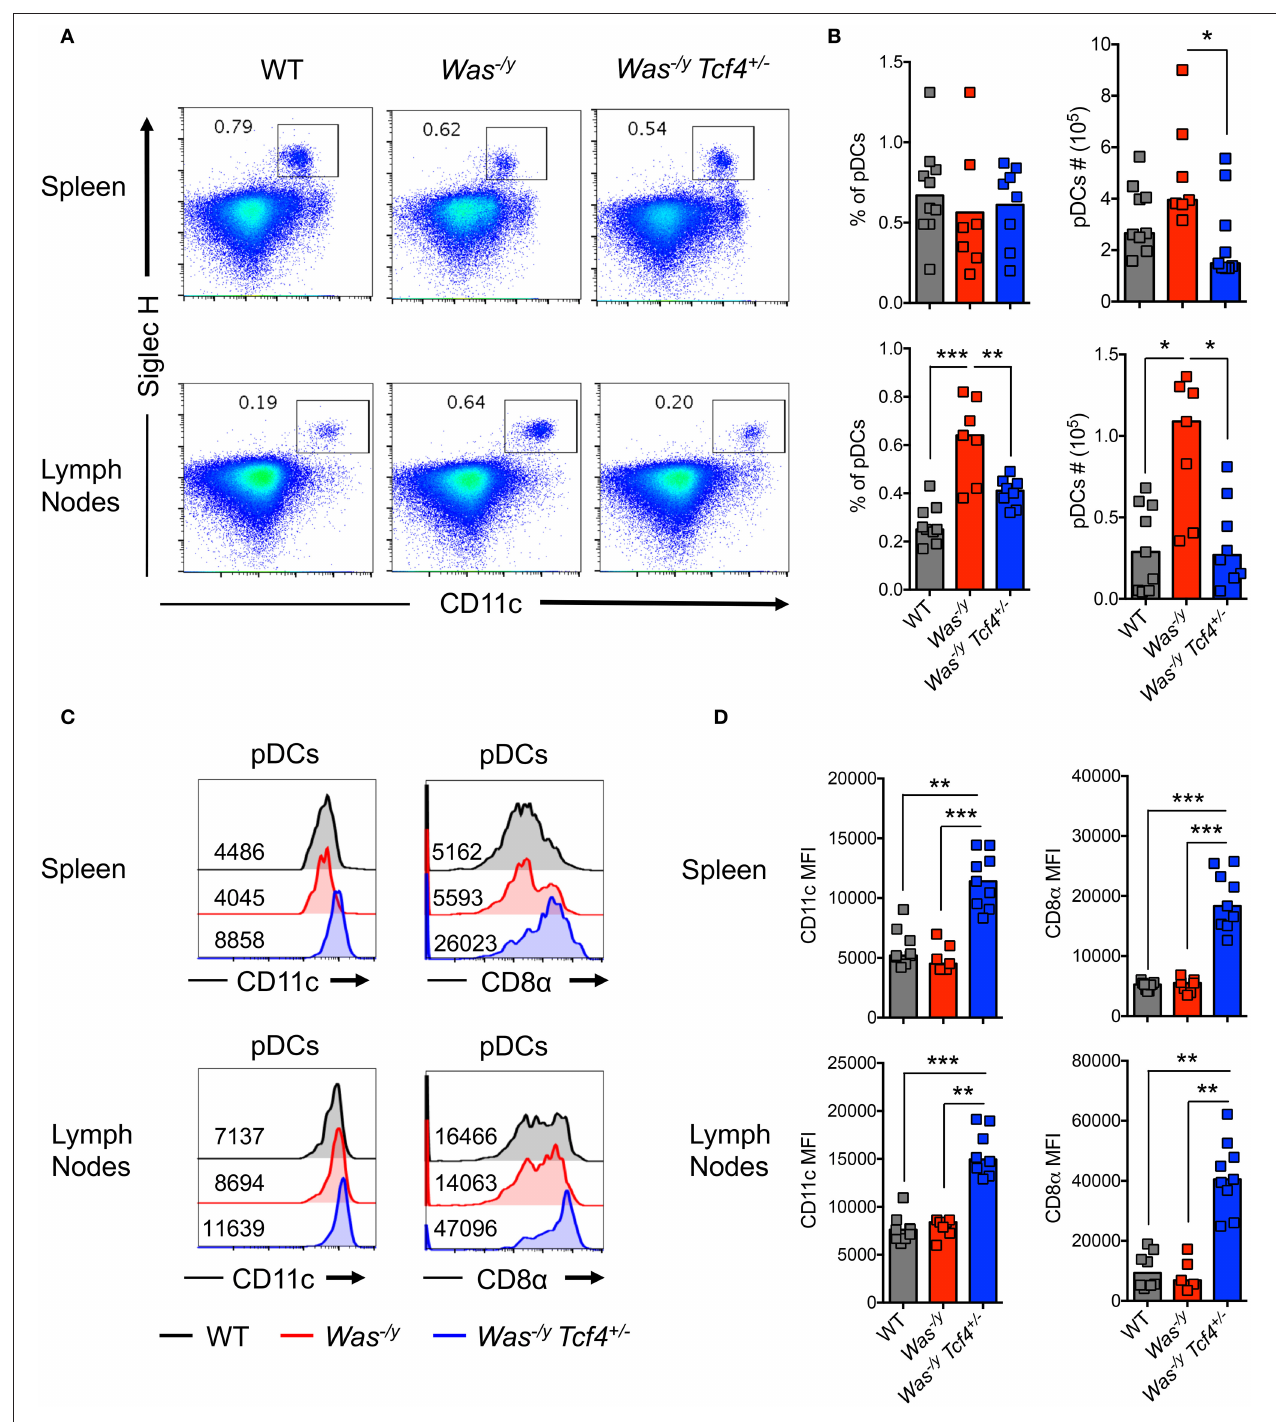
FIGURE 1 | Reduced numbers and altered phenotype of pDCs upon Tcf4 haplodeficiency in Was -deficient mice.WT, Was − / y or Was − / y Tcf4 + / − mice were analyzed at 30 weeks of age. (A) pDCs were identified by flow cytometry analysis of CD11c and Siglec H expression from CD11b − live cells in the spleen and LNs. The frequency of pDCs is indicated in each plot. (B) Frequency and absolute numbers of pDCs (CD11b − CD11c + Siglec H + pDCs among total live cells) in the spleen and LN of individual mice are shown. Horizontal bars indicate median value. Data were pooled from 4 independent experiments. (C) CD11c and CD8 α expression with the mean fluorescent intensity (MFI) indicated on pDCs (CD11b − CD11c + Siglec H + ) from the spleen and LN as analyzed by flow cytometry. (D) MFI of CD11c and CD8 α on pDCs from the spleen and LN of each individual mice as pooled from 4 independent experiments. Horizontal bars indicate the median. Statistical significance estimated by Kruskal-Wallis test followed by a post-hoc Dunn’s multiple comparison test is indicated as follows * P ≤ 0.05, ** P ≤ 0.01, *** P ≤ 0.001.